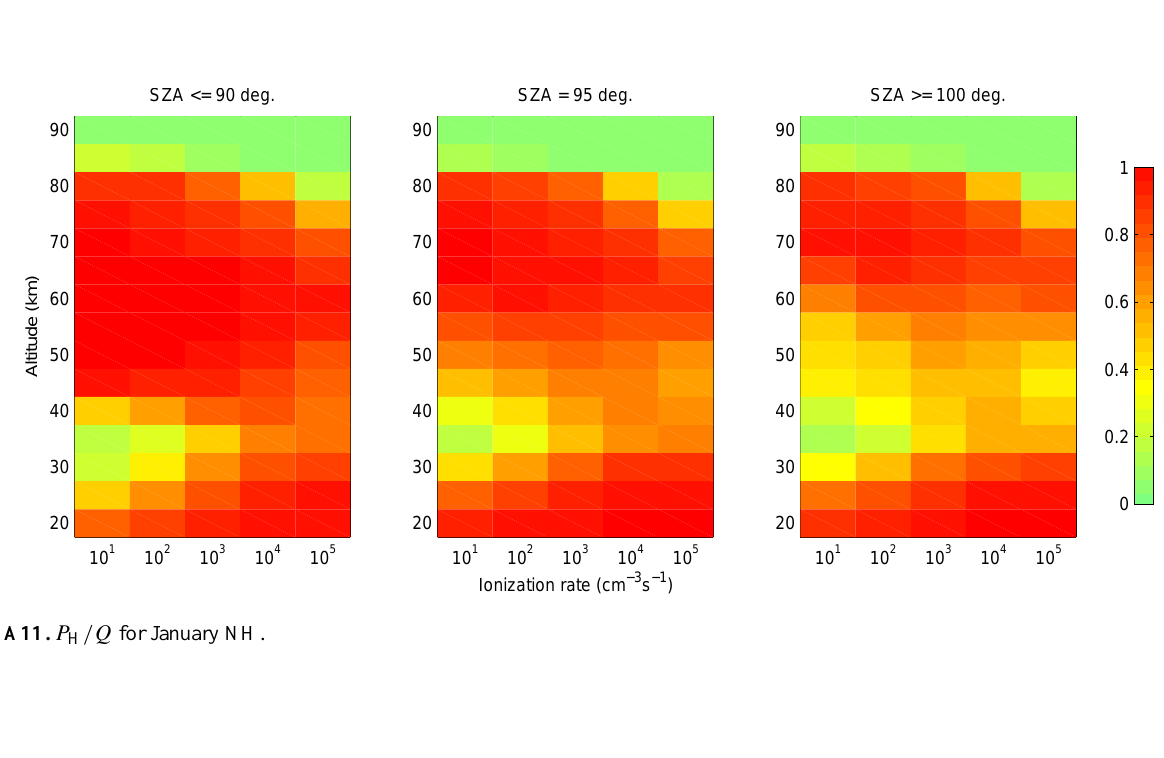
Fig. A11. P H /Q for January